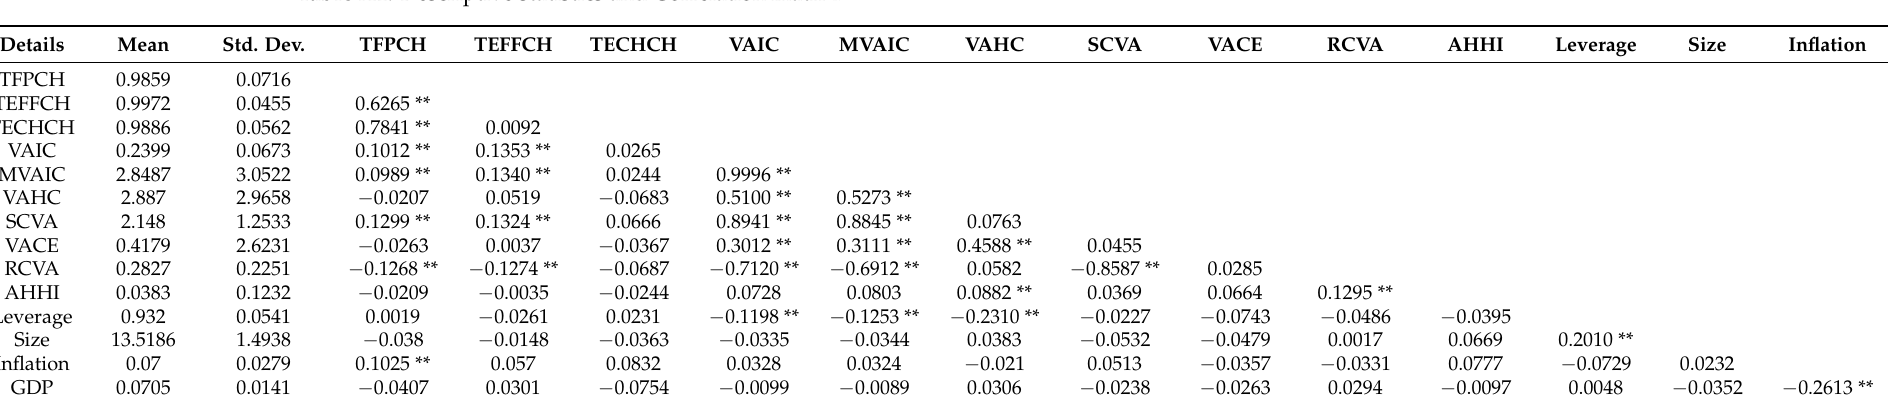
Table A1. Descriptive statistics and Correlation